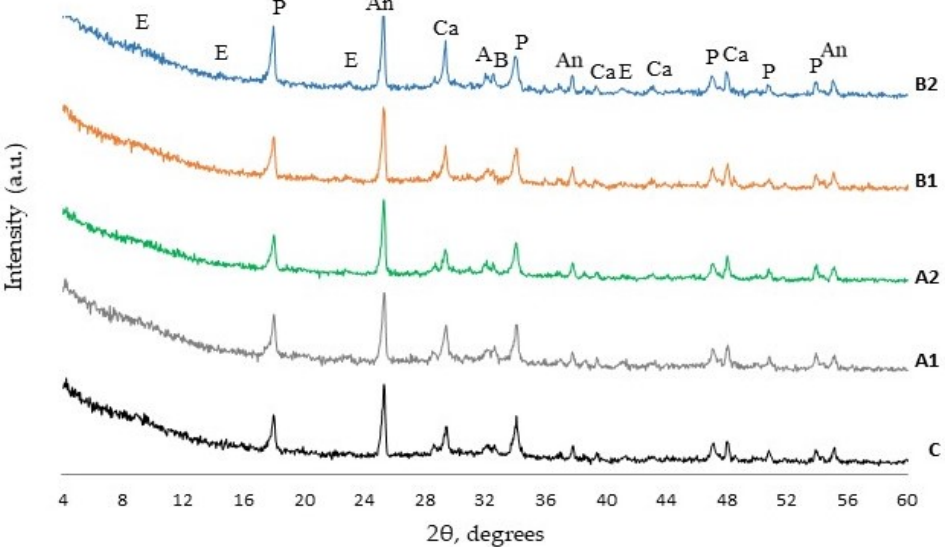
Figure 8. XRD diffractogram of hardened blended cement paste after 28 days curing (E—ettringite,